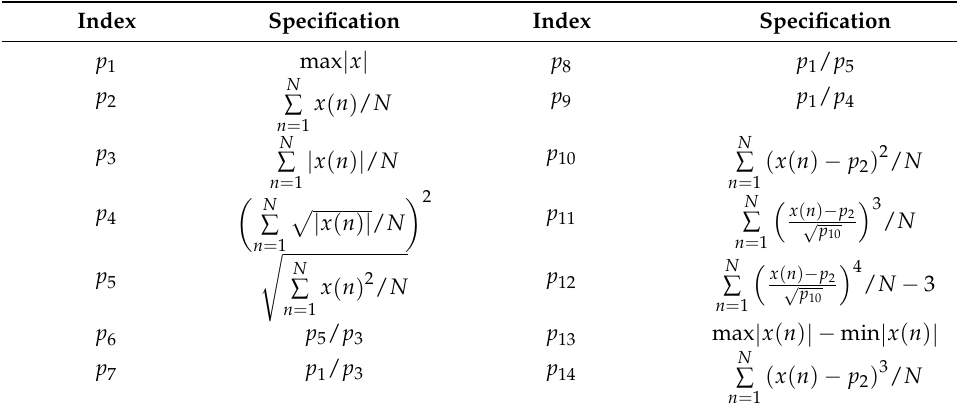
Table 1. Statistics of WPT